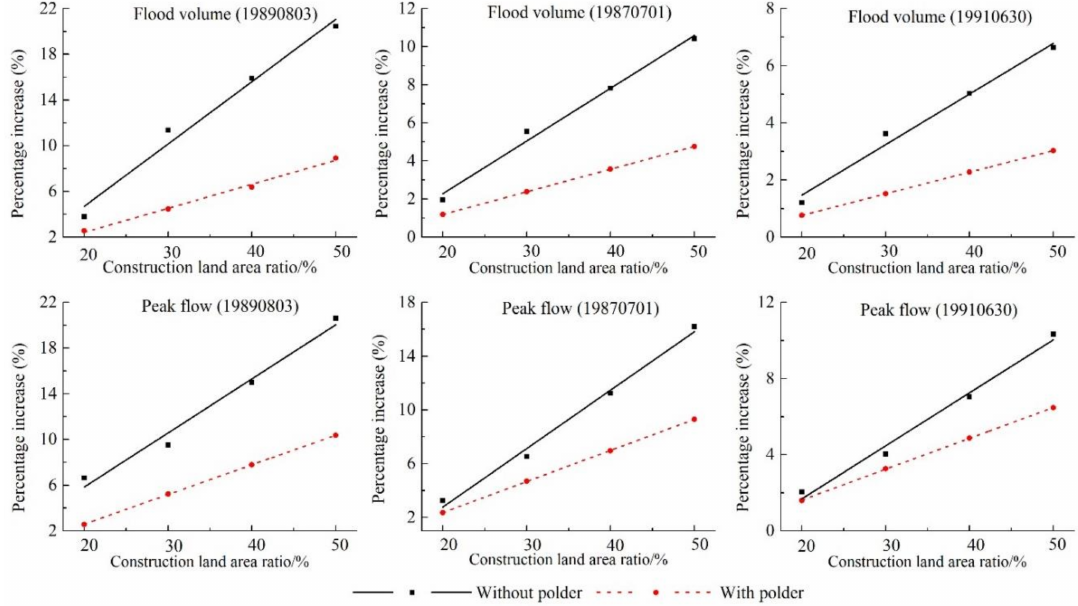
Figure 5. The potential changes of percentage increases in Q v and Q p from scenario A under the without polder and with polder conditions for different flood